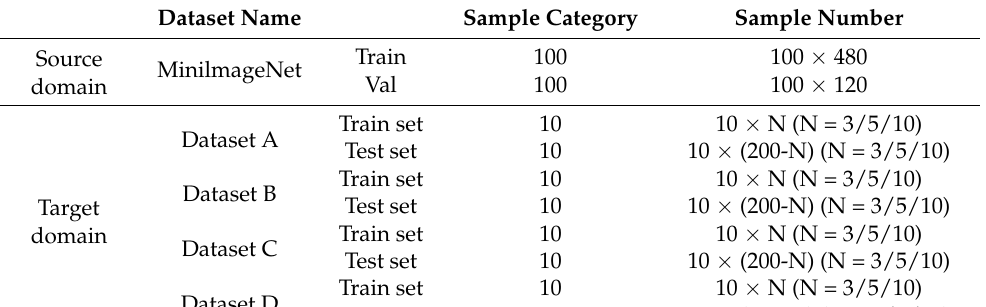
Table 3. Description of the datasets.